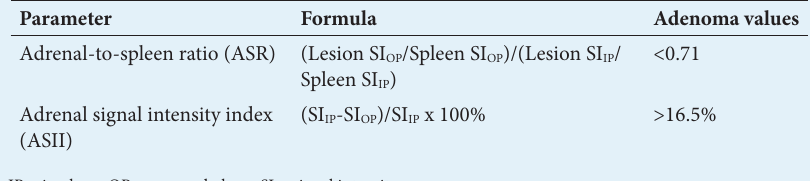
Table 2. Chemical shift MRI quantitative analysis for adenoma characterisation Parameter